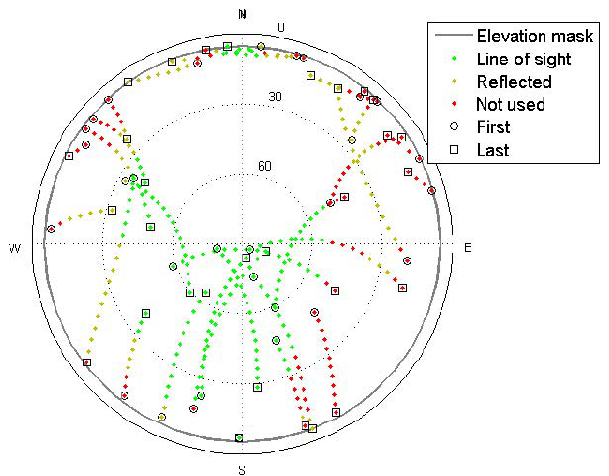
Figure 11: Skyplot with satellites tracks during the 2 hours and 40 minutes used for the test. Color coding indicates whether the signals are direct, reflected or not used in the position estima- tion.